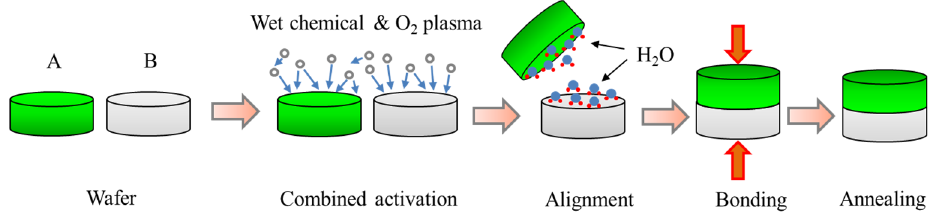
Figure 1. Schematic illustration of Si/Si wafer direct bonding by combined hydrophilic activation method.